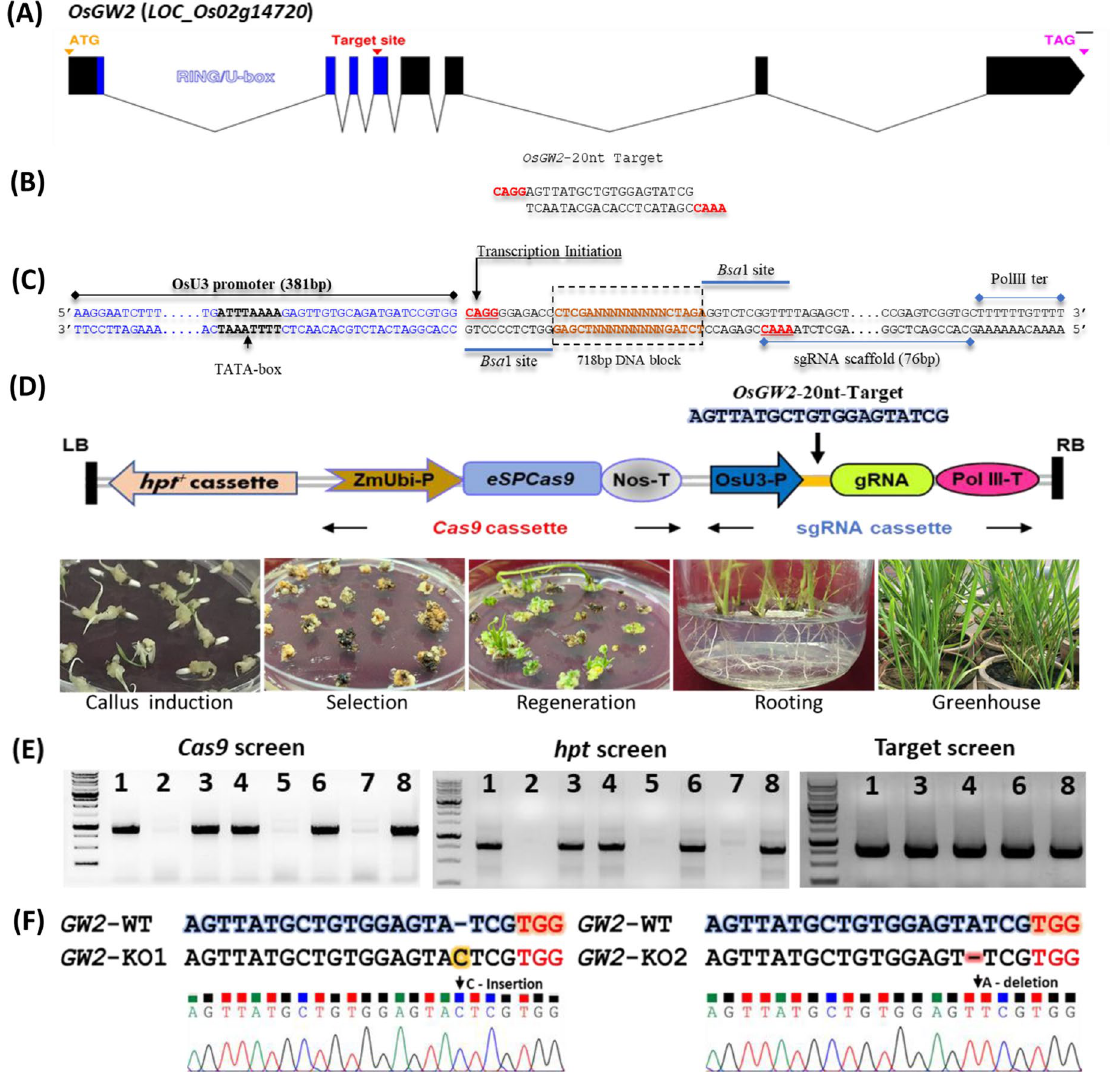
Figure 1. Structural organization of OsGW2 , eSpCas9 expression cassette and mutation analysis. ( A ) Rice GW2 gene consisting of 8 exons interrupted by 7 introns and RING-U box domain highlighted blue. The structural organization of OsGW2 gene was graphically represented using exon–intron graph maker (http:// wormw eb. org/ exoni ntron). The 20nt-sgRNA target site was selected at RING/U box domain. ( B ) Specific 20-nt sgRNA target sequence along with Bsa I cloning sites. ( C ) sgRNA expression cassette showing rice U3 promoter and polIII terminator consisting two Bsa I restriction sites separated by a 718 bp DNA block. ( D ) T-DNA border having genome editing tools ( eSPCas9 and sgRNA) in pMDC99 vector. The lower figure ( D ) represents different stages of plant development following tissue culture methods. (E) PCR confirmation of T0 plants showing presence of Cas9 (887 bp) and hpt (954 bp) genes. The last figure ( E ) showing PCR amplification of 746 bp flanked sequence including the 20nt target region from the Cas9 positive plants for identification of INDEL mutations. ( F ) Genotyping confirmation of GW2 -KO mutant lines showing C-insertion ( GW2 -KO1) and A-deletion ( GW - KO2) mutation generated by Cas9 nuclease. The image was created by chromatogram viewer Chromas 2.6.6 software (http:// techn elysi um. com. au/ wp/ chrom dependent on the gRNA sequence and its secondary structure. The effect of INDEL mutations on the full-length protein frame were predicted using Expasy bioinformatic tool. Both the C-insertion and A-deletion mutation end up with truncated GW2 peptides (Supplementary Fig. S9). Seeds from GW2 -KO1 and GW2 -KO2 homozy- gous mutants were harvested at maturity, and T2 seedlings were raised. The T-DNA free GW2 -KO mutant lines with above mutation types were identified in the T2 progeny. The T3 GW2 -KO mutant plants were advanced to next the generation. The above mutations were inherited in the next generation progeny which was confirmed through Sanger sequencing. All the agronomic and morphological parameters were measured in the T-DNA free GW2 -KO homozygous mutant lines.